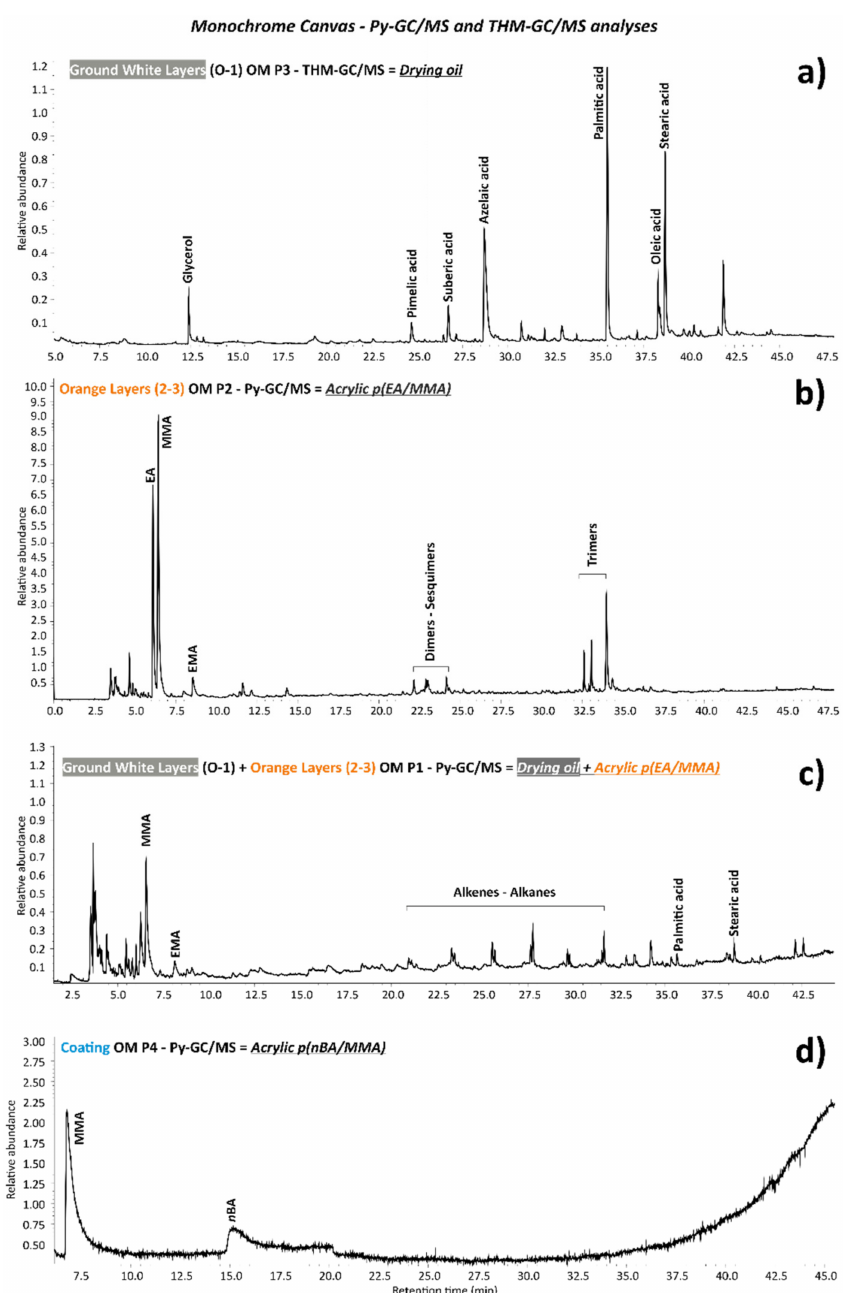
Figure 6. Pyrograms of the white ground layers ( a ) 0 and 1 of OM P3 sample acquired by TMH–GC/MS showing the most important marker peaks of a drying oil binder, ( b ) orange lay- ers (2–3) of OM P2 sample by Py–GC/MS with the peaks of an EA/MMA acrylic binder, ( c ) both ground layers and orange layers of the OM P1 sample by Py–GC/MS with their respective peaks, and ( d ) coating/varnish layer of the OM P4 sample by Py–GC/MS depicting the main peaks of an nBA/MMA